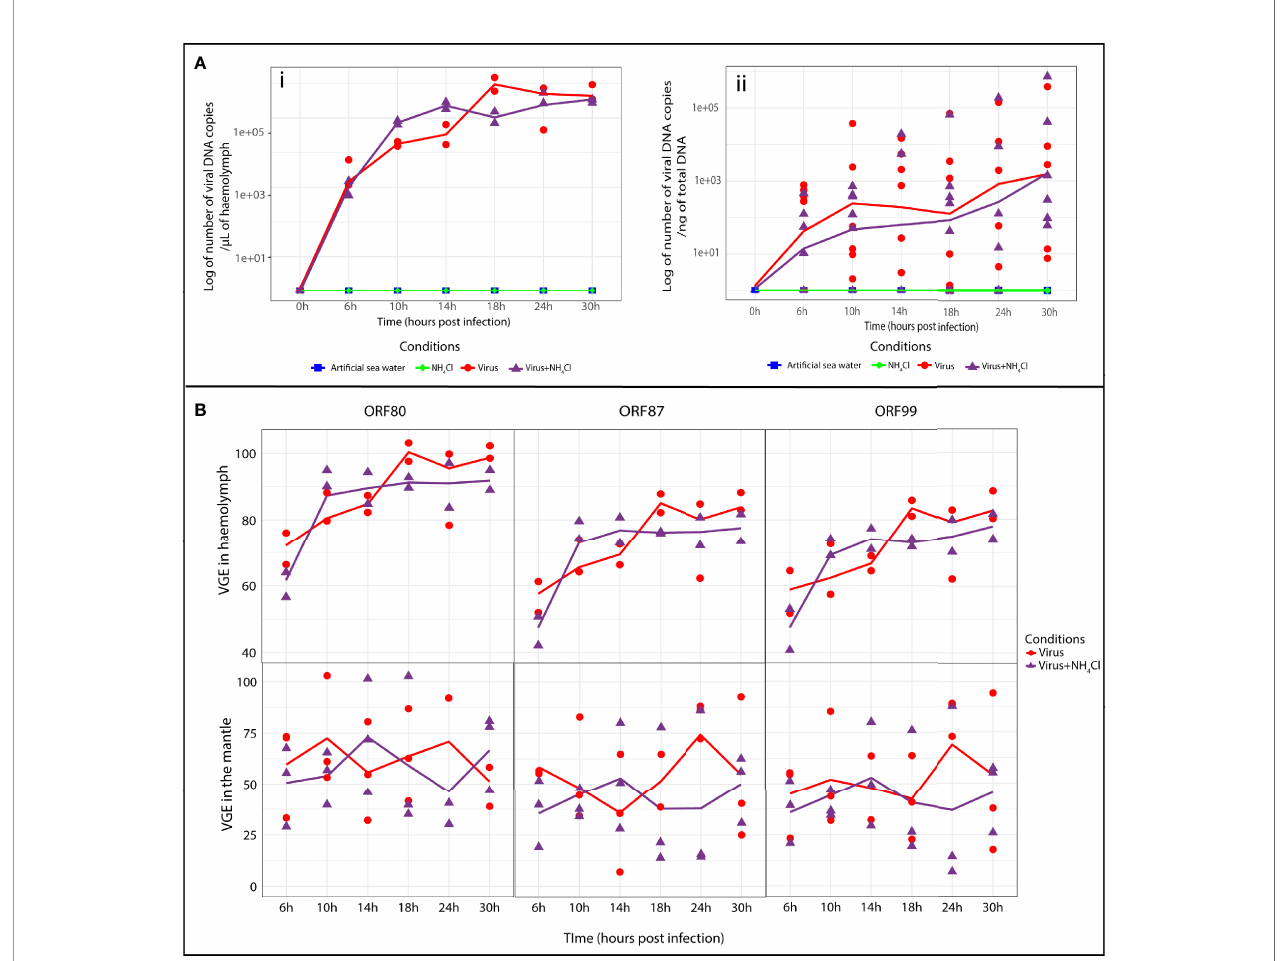
FIGURE 2 | Detection of OsHV-1 DNA and RNA in haemolymph and mantle of Crassostrea gigas . (A) Viral DNA amounts detected by real time PCR in Paci fi c oysters of the four different tested conditions (arti fi cial seawater, NH 4 Cl, virus and virus+NH 4 Cl) after injection by OsHV-1 (i) in haemolymph (n=2 pools of 15 animals) and (ii) in the mantle. (n=6 animals) The line represents the trend curve of viral DNA amount in the virus condition (red line) and the virus+NH 4 Cl condition (purple line). No signi fi cant difference was observed between the virus and virus+NH 4 Cl conditions in the mantle and haemolymph. (B) Relative genes expressions of ORF 80, ORF 87 and ORF 99 estimated by RT-PCR at different time of exposure for the virus and virus+NH 4 Cl condition in haemolymph (n= 2 pools of 15 animals) and mantle (n=3 animals). The line represents the trend curve of the expression of each gene in the virus condition (red line) and the virus+NH 4 Cl condition (purple line). No signi fi cant difference was observed between the virus and virus+NH 4 Cl condition in haemolymph and the mantle of the Paci fi c oyster. VGE, viral gene